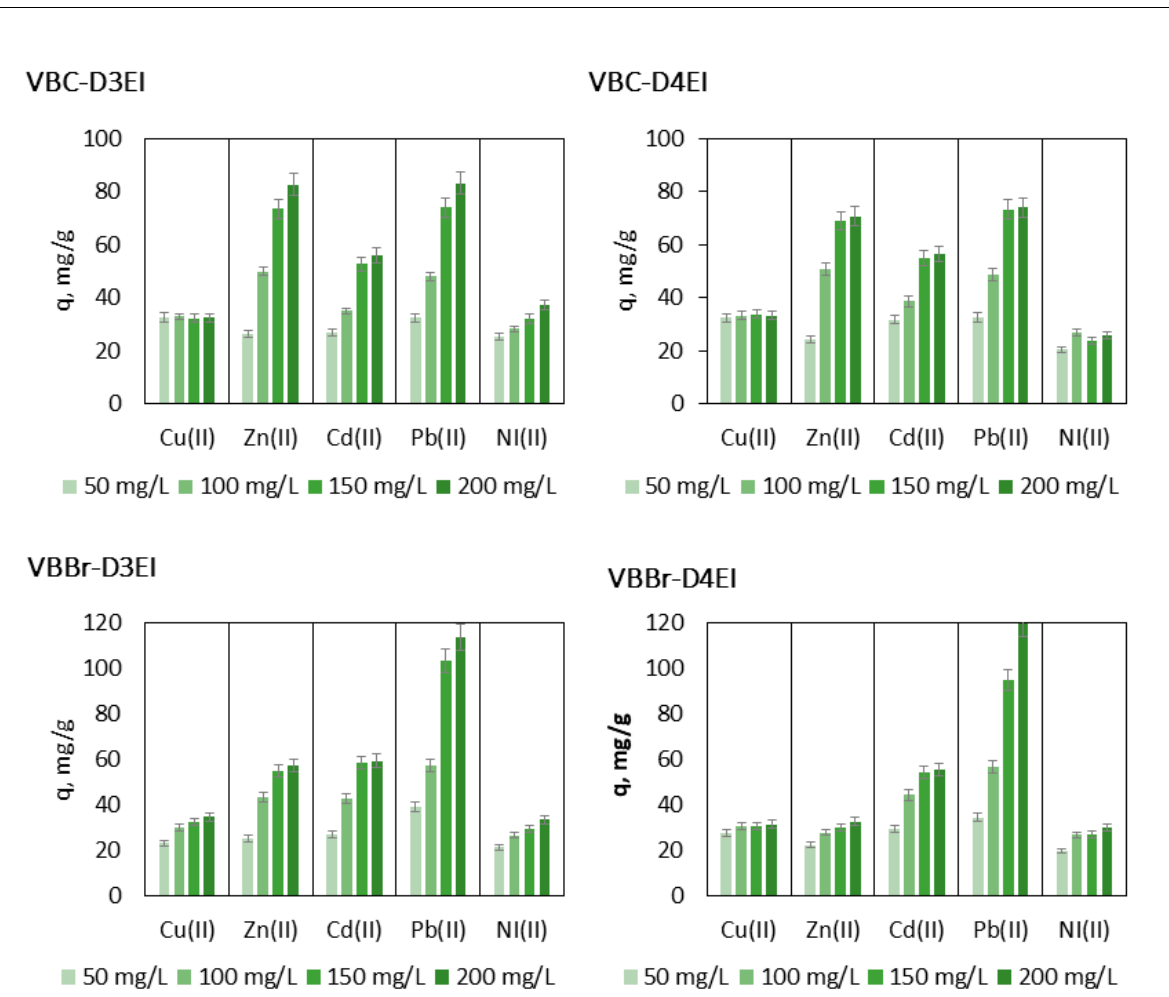
Figure 9. Effect of shaking time on sorption of Pb(II), Cu(II), Ni(II), Zn(II), and Cd(II) onto resin surfaces (metal ions concentrations, 50 − 200 mg/L; sorbent dosage, 0.1 g; V, 100 mL, pH 5).